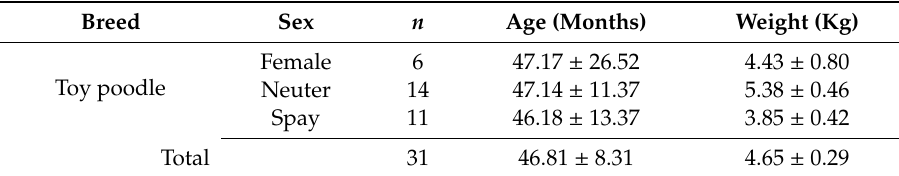
Table 1. Information on the dogs used in the present study.